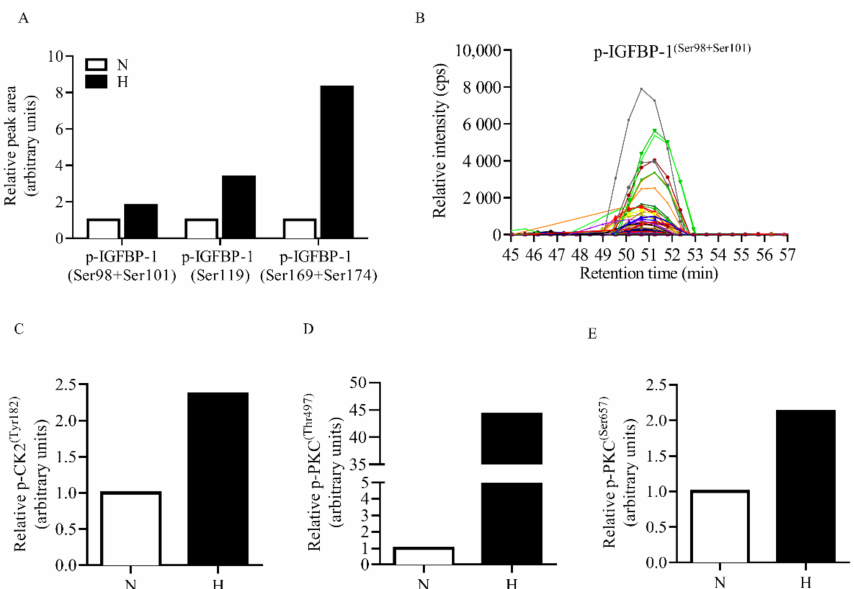
Figure 4. PRM-MS to monitor relative site-specific phosphorylation in hypoxia. Relative phospho- rylation of IGFBP-1 ( A ) from normoxic (N) (incubator air) and hypoxic (H) (1% O 2 ) conditions in immunoprecipitated (IP) samples using IGFBP-1 antibody. ( B ) PRM-MS transitions are shown in a representative chromatograph used to monitor phosphorylation of IGFBP-1. Peak retention time of IGFBP-1-specific peptides shown in color indicate that transition ions result from the same parent peptide. (Please refer to Supplemental Table for transition list). Phosphorylation of IGFBP-1 co-immunoprecipitated CK2 and PKC kinases was also monitored to determine activation status; p-CK2 (Tyr182) ( C ), p-PKC (Thr497) ( D ), and p-PKC (Ser657) ( E ) were individually monitored in control and hypoxic conditions. Data was collected using a Q-Exactive hybrid quadrupole-Orbitrap mass spectrometer. Values are displayed as relative peak area of total detected transitions and normalized by an internal IGFBP-1